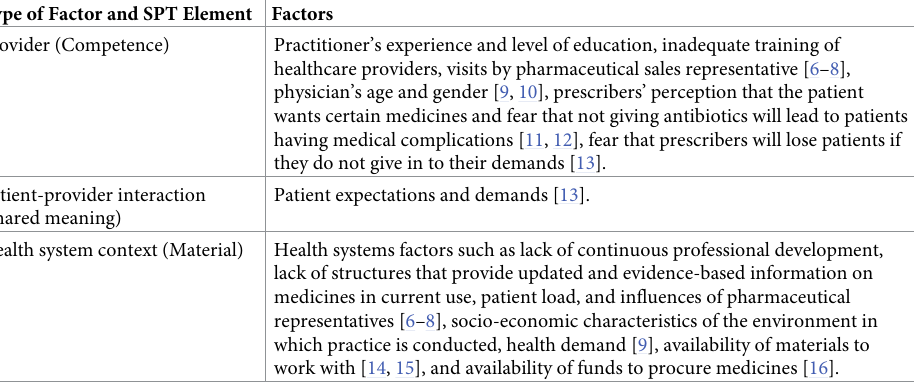
Table 1. Factors affecting prescribing behaviours and how they link to the